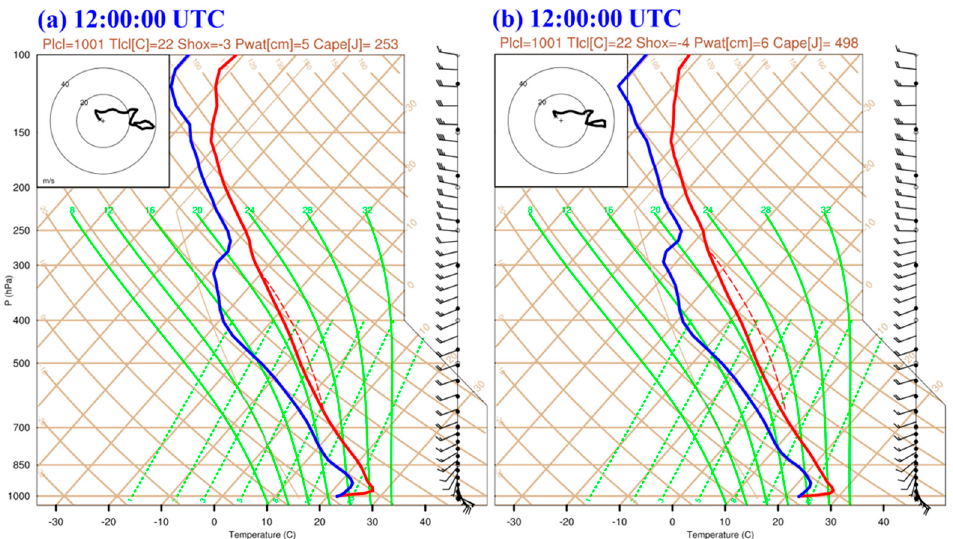
Figure 4. Panel ( a ) is the simulated hodograph and skew-T plot of 12:00:00 UTC 14 May 2021 at the location where transmission line towers toppling appeared. Panel ( b ) is the same as ( a ) but for the ERA5-based hodograph and skew-T plot. Plcl = pressure of the lifted condensation level (hPa); Tlcl = temperature of the lifted condensation level (°C); shox = showalter index; Pwat = precipitable water (cm); Cape = convective availabe potenrial energy (J kg − 1 ).